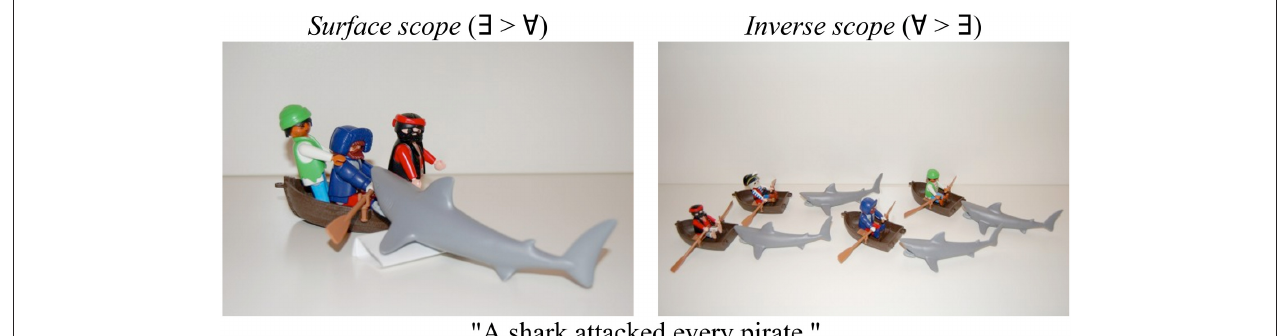
FIGURE 4 | An example item from Scontras et al. (in press).